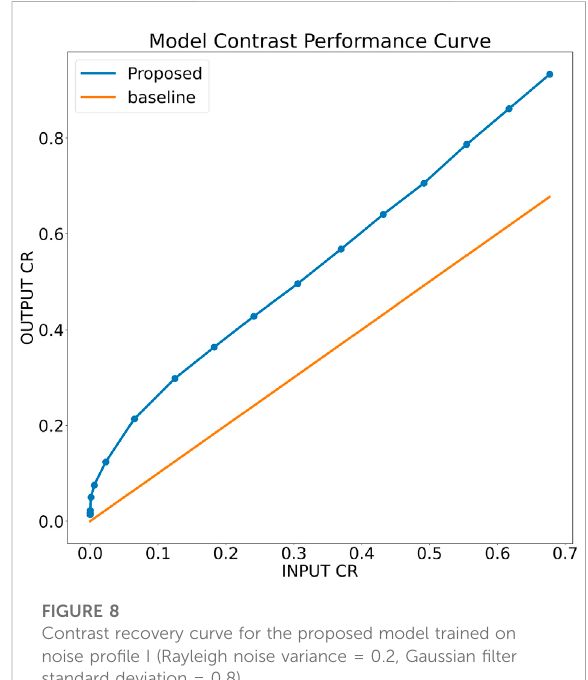
FIGURE 8 Contrast recovery curve for the proposed model trained